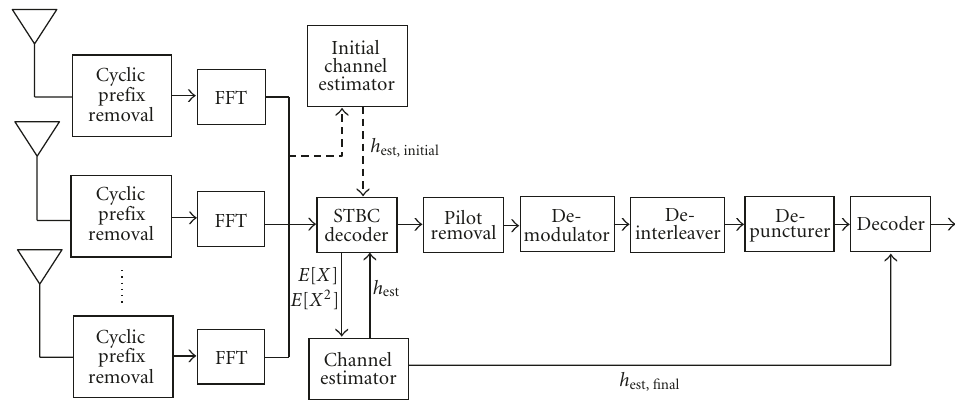
Figure 2: OSTBC OFDM